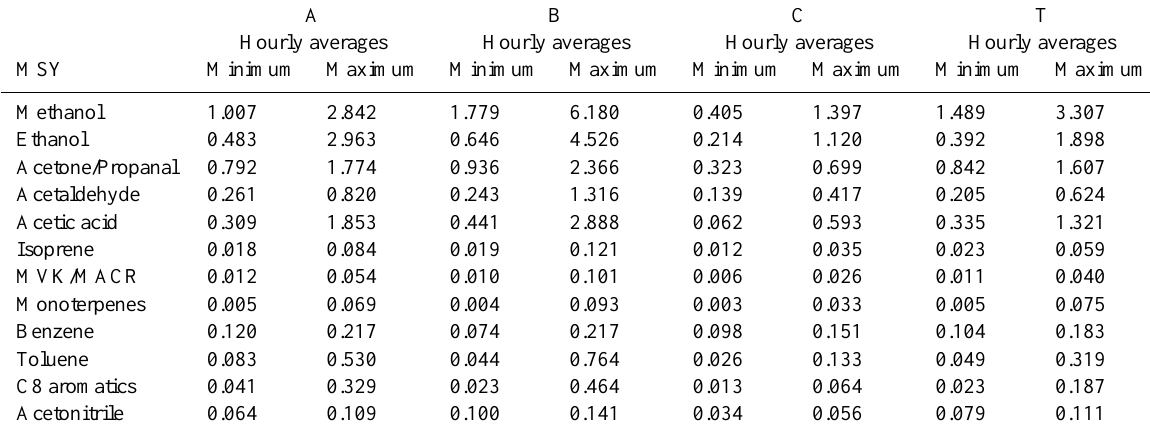
Table 4. Minimum and maximum hourly averaged VOC mixing ratios (ppbv) recorded at the MSY station during each of the atmospheric scenarios (A, B, C, T) described in Sect. 2.4. These values correspond to the data displayed in Figs. 6–8.